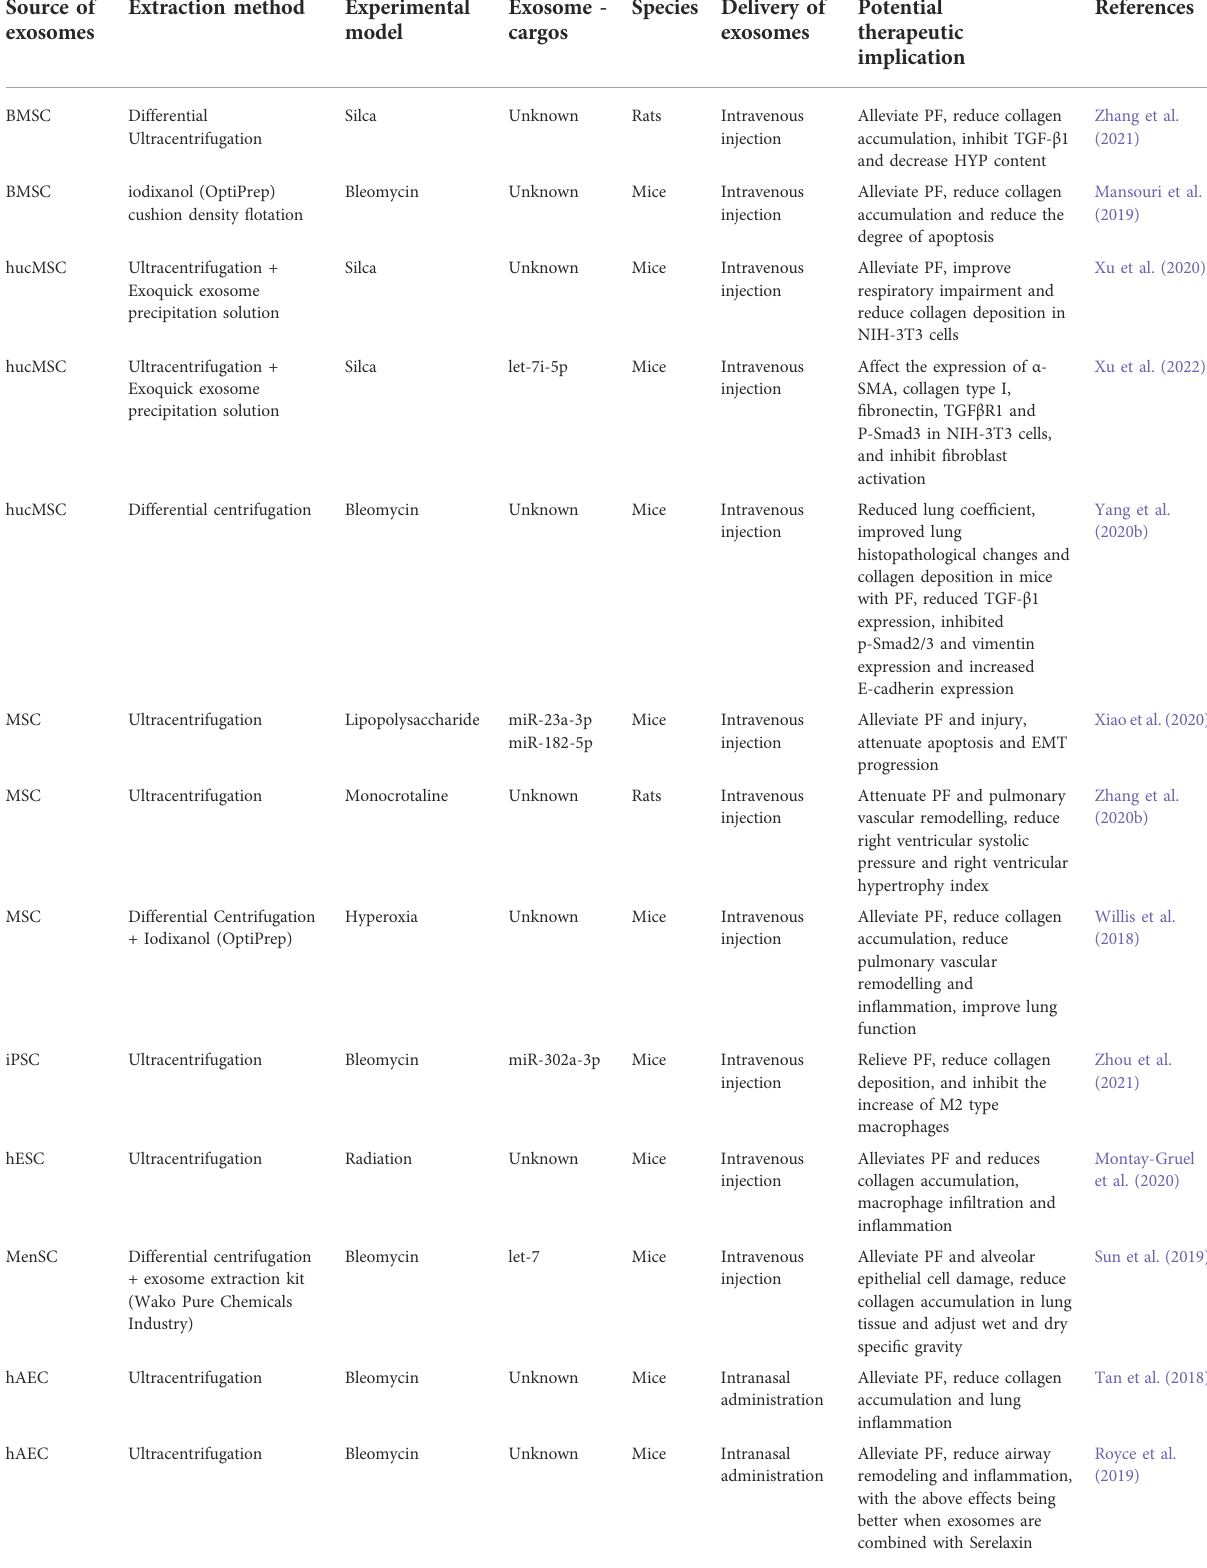
TABLE 2 Potential therapeutic implication of exosomes in